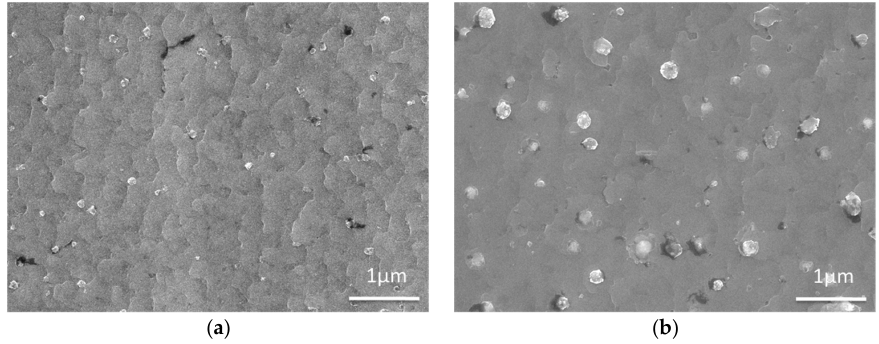
Figure 6. SEM images of the GdYBCO films prepared based on the slit shower. ( a ) SEM image of the edge position; ( b ) SEM image of the middle position.